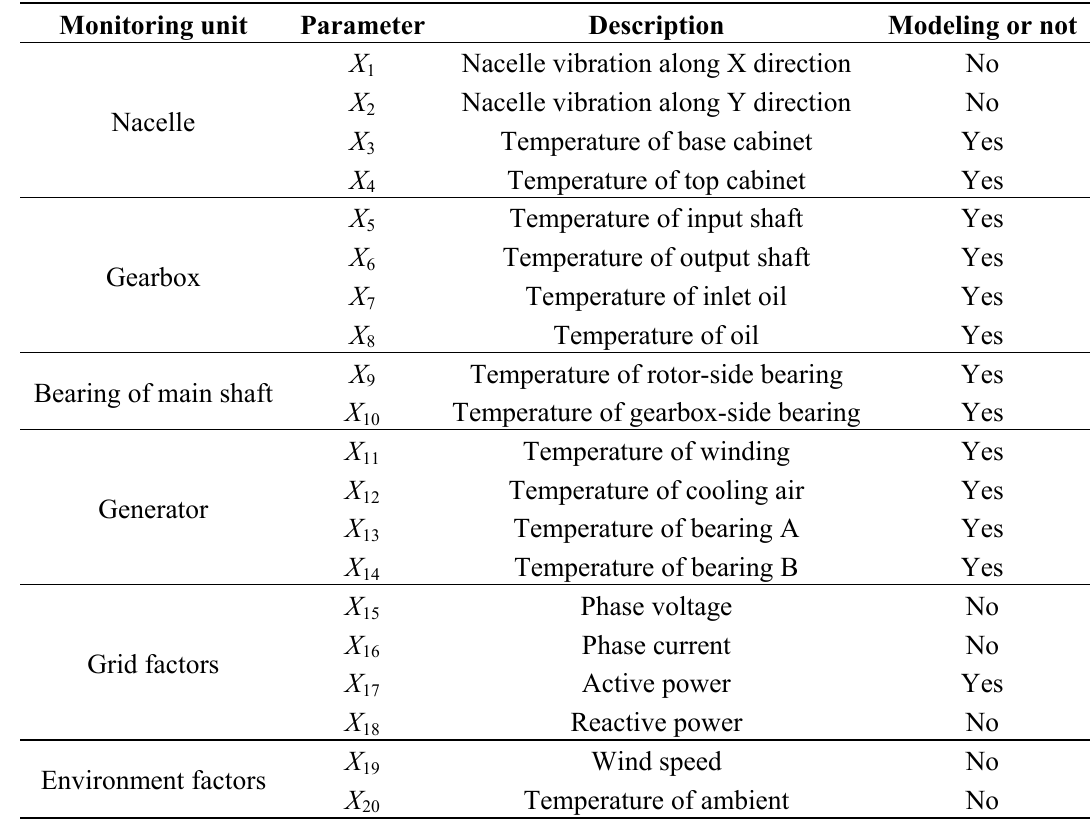
Table 1. Part of condition parameters of wind turbines.